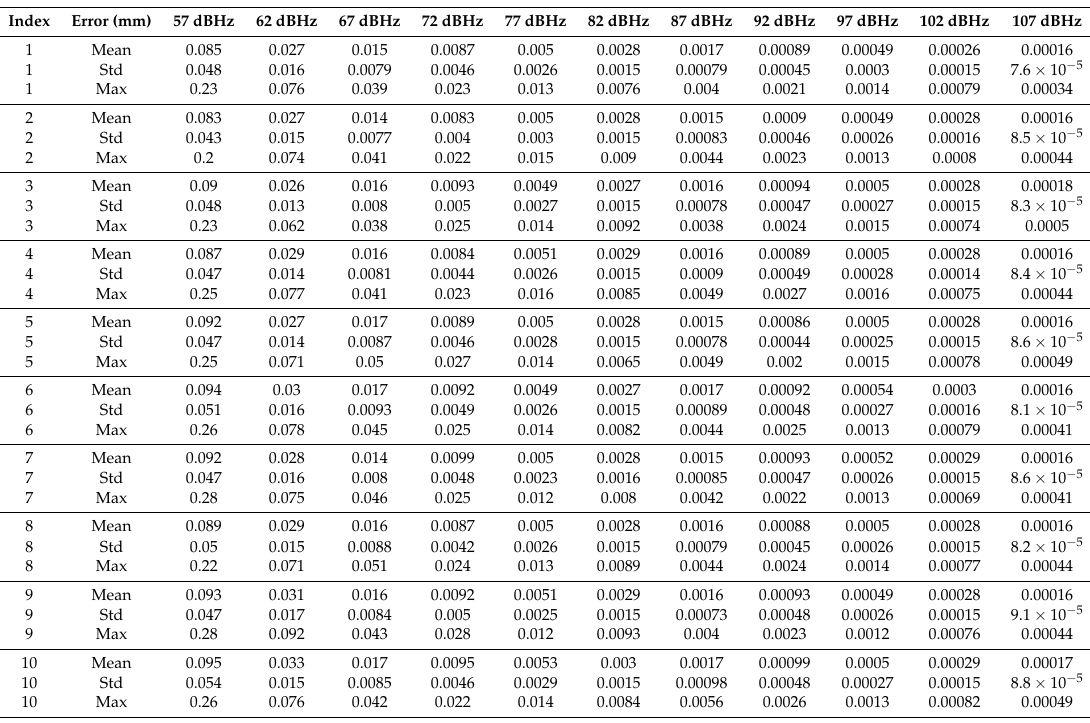
Table 2. Mean values, standard deviation, and maximum error values in the calculation of the impact point using FDMA with IQ with a 10-bit size.